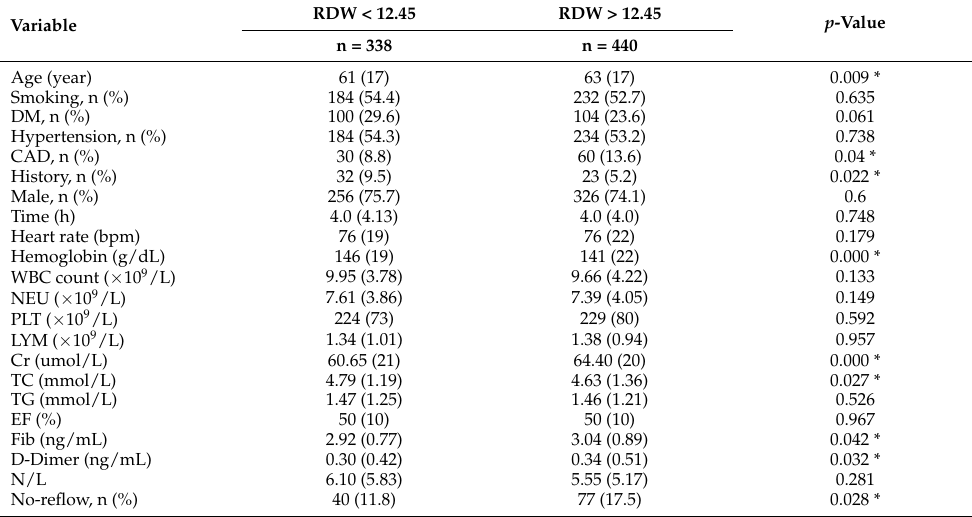
Table 1. Basic characteristics of patients with RDW difference.